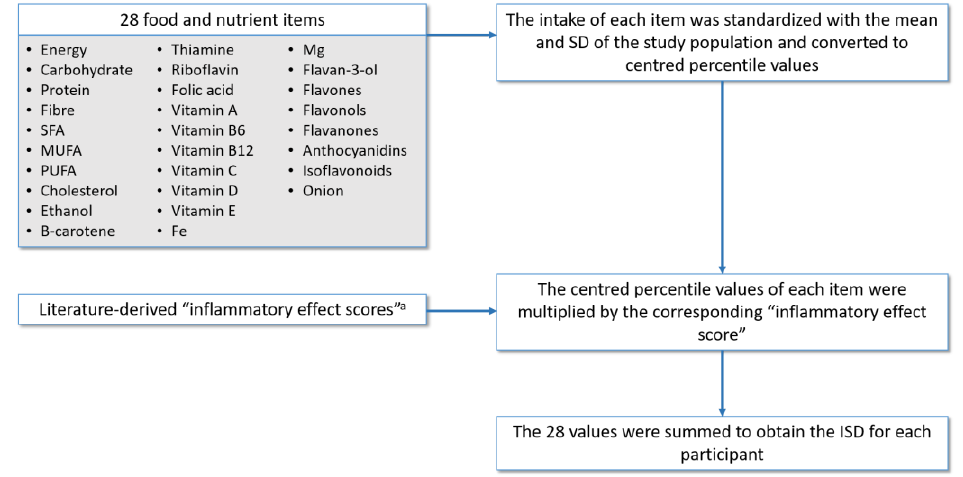
Figure 1. Construction of the inflammatory score of the diet (ISD). SFA: saturated fatty acids, MUFA: monounsaturated fatty acids, PUFA: polyunsaturated fatty acids. a The inflammatory effect scores used are those reported by Shivappa et al. [20].